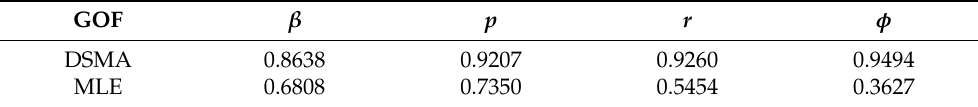
Table 4. GOF of different linearization models of aircraft motion to flight test